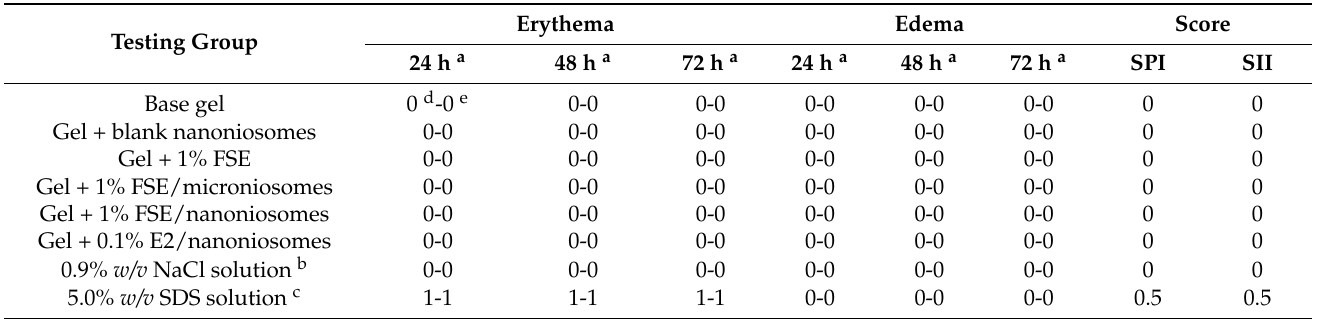
Table 3. Skin irritation scores after patch test of FSE microniosomes and nanoniosomes in rabbits. Testing